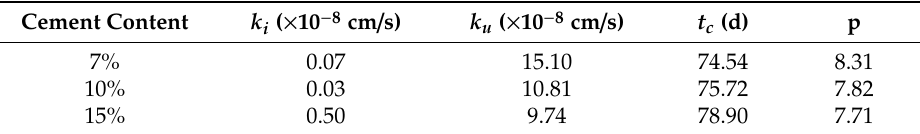
Figure 15. Fitting curves of the permeability coe ffi cient of the deteriorated